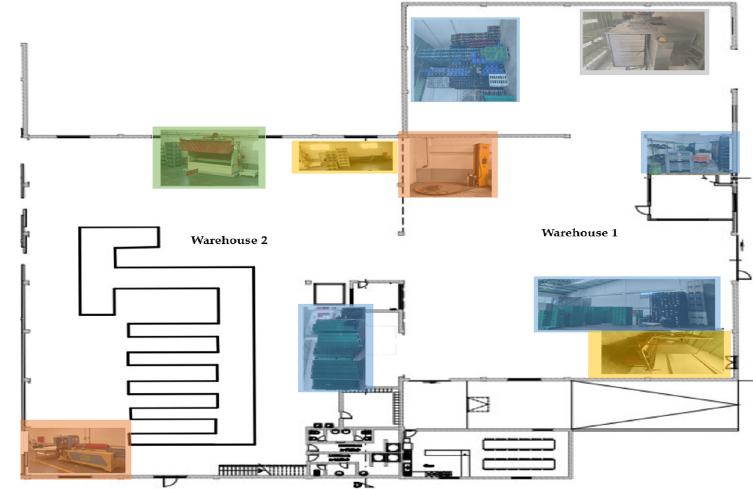
Figure 2. Distribution of machines in the facility.